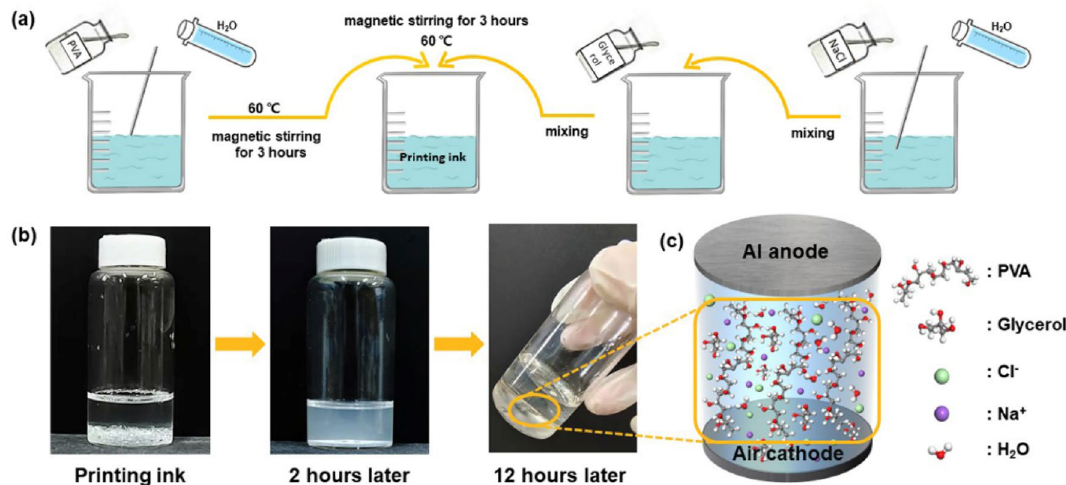
Figure 8. ( a ) The schematic illustration of synthesis of the printing ink. ( b ) Optical image of the printing ink changes over time. ( c ) Schematic diagram of Al–air battery structure and the electrolyte composition (Microsoft Office Hone and Student 2019-zh-cn https:// www. micro softs tore. com. cn/ softw are/